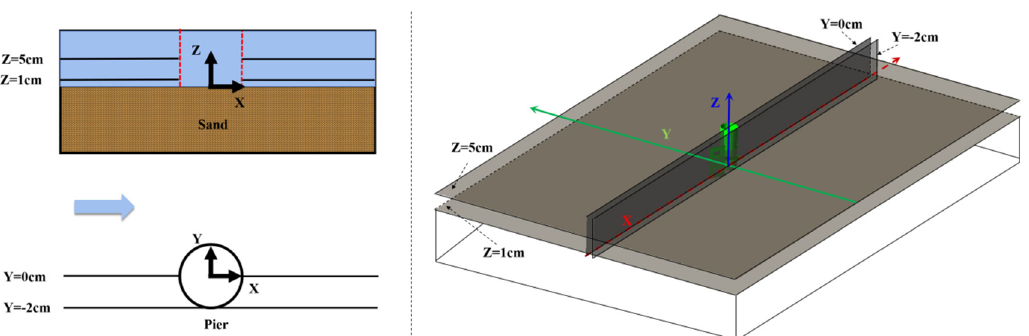
Figure 3. Test planes of flow field.